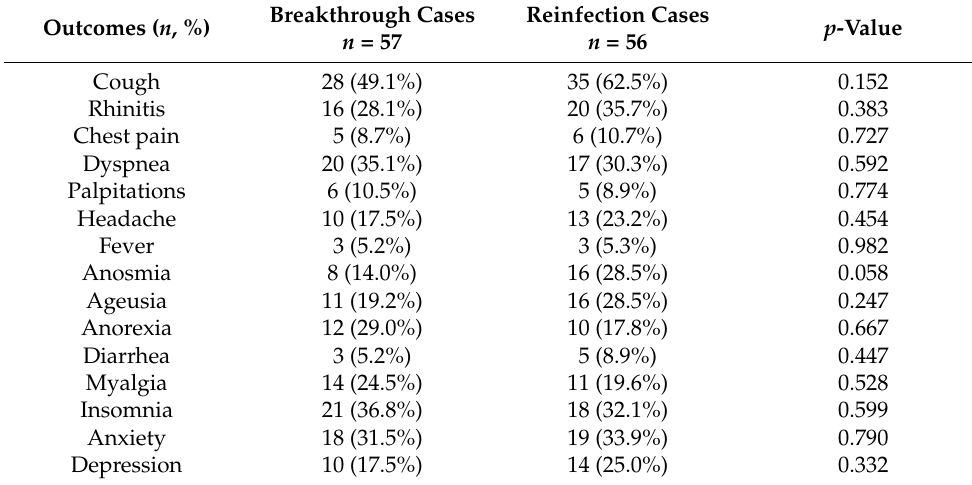
Table 2. Patient outcomes after hospital discharge.